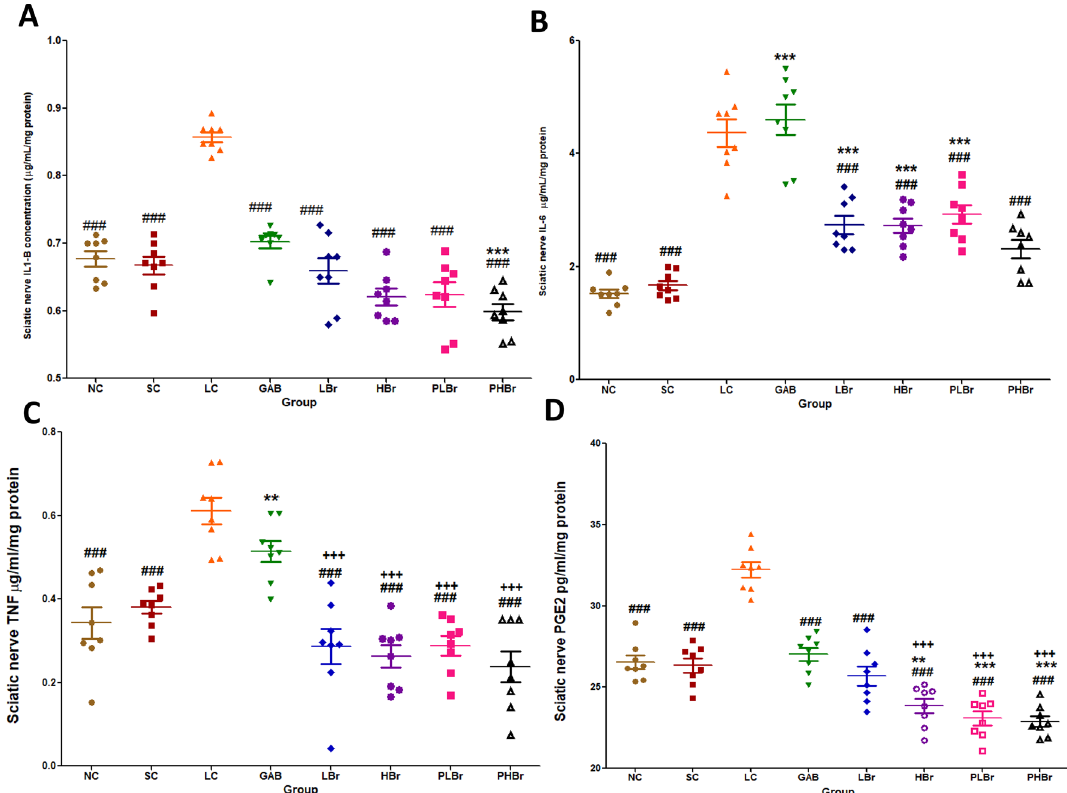
( D ) PGE 2 concentration. # p < 0.05, ## p < 0.01, ### p < 0.001 compared with ligated control; *p < 0.05, **p < 0.01, ***p < 0.001 compared with normal control; + p < 0.05, ++ p < 0.01, +++ p < 0.001 compared with reference control. NC: Unligated Normal Control; SC: Sham Control; LC: Ligated Control; GAB: Gabapentin Reference Control (30 mg/kg gabapentin); LBr: Low Dose Bromelain (30 mg/kg); HBr: High Dose Bromelain (50 mg/kg); PLBr: Pre-treated Low Dose Bromelain (30 mg/kg); PHBr: Pretreated High Dose Bromelain (50